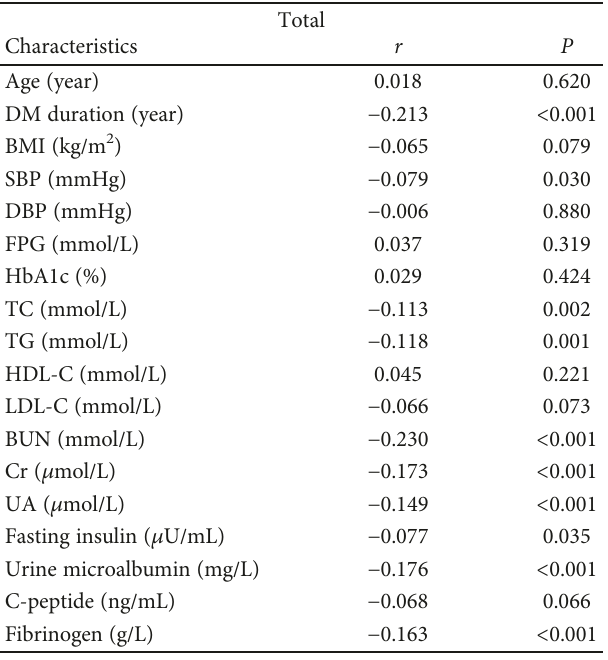
Table 2: Correlation of STBC and various clinical parameters in total subjects.